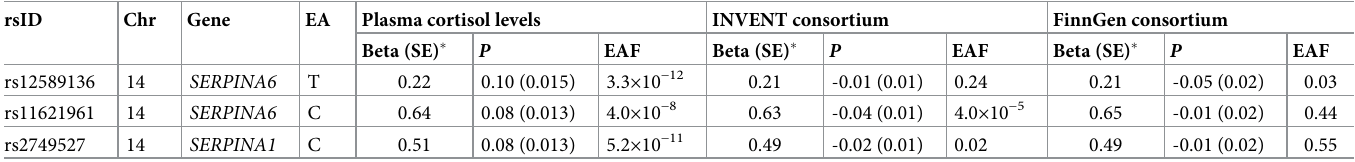
Table 2. Characteristics of the genetic variants used as instrumental variables for cortisol levels and their associations with venous thromboembolism in the INVENT and FinnGen